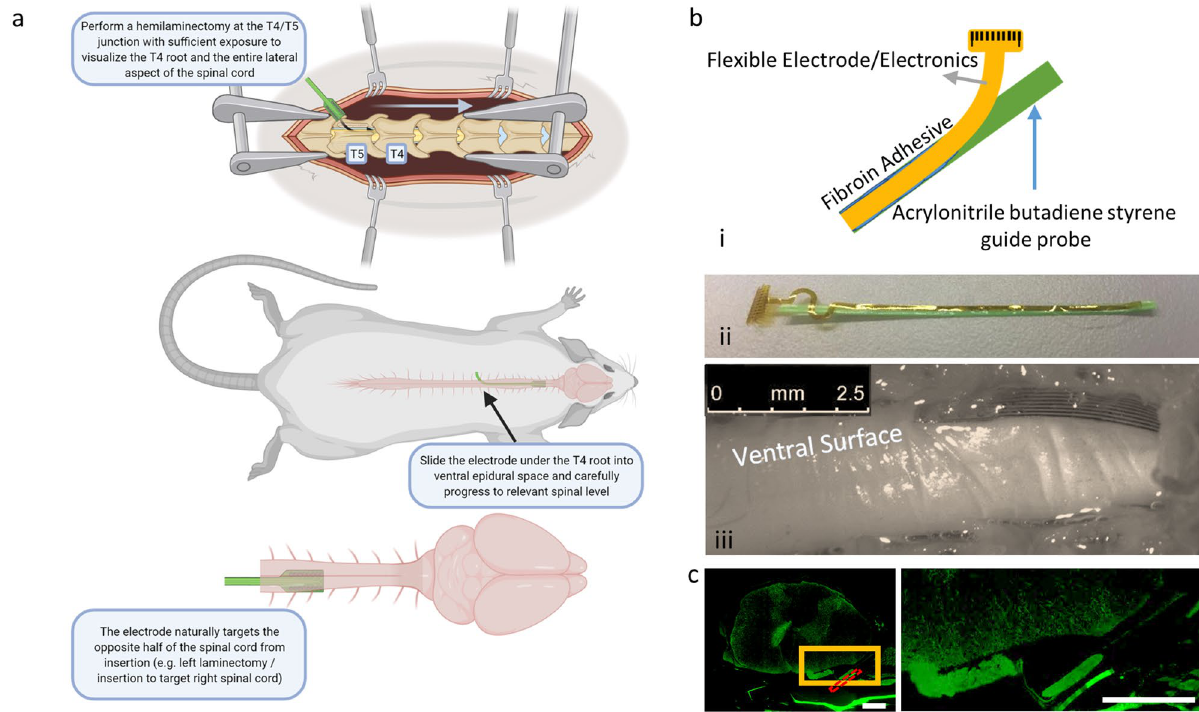
Figure 2. Surgical approach. ( a ) We developed a technique to insert highly flexible electronics into the ventral aspect of the cervical rat spinal cord using a dorsal thoracic approach. ( b ) (i) low bending stiffness biocompatible arrays were fixed to a 3D printed guide probe with biocompatible silk polymer fibroin to (ii) aid in insertion. (iii) Following 2 months of implantation, the array remained positioned at the C5/C6 spinal level lateral to midline. ( c ) IHC stains for GFAP revealed low bending stiffness arrays do not exhibit enhanced GFAP signal (green) near the spinal surface most proximal to the array, though arrays do appear to become encapsulated in connective tissue over time. Red dashed box—approximate array location, yellow box—location of inset, *all scale bars indicate 500